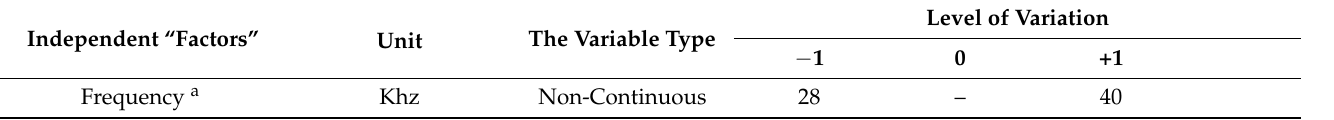
Table 1. Design of experiment by RSM. The number and description of factors and responses implemented. Level of Variation Independent “Factors” Unit The Variable Type − 1 0 +1 Frequency a Khz Non-Continuous 28 –